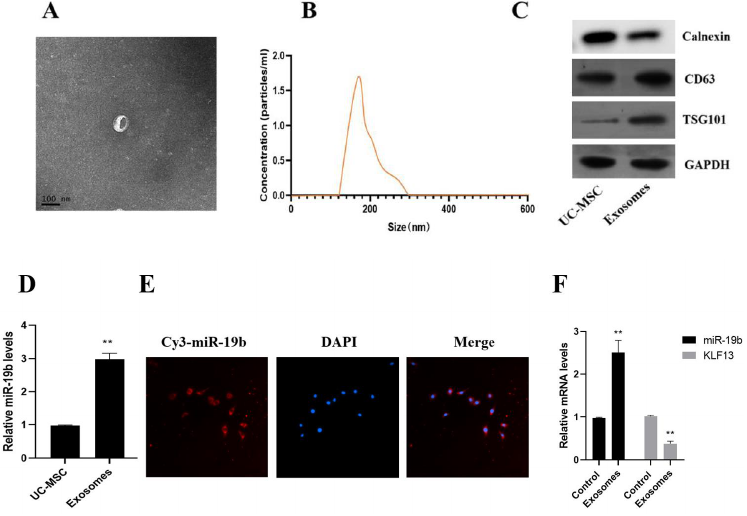
Figure 5. Isolation and characterization of exosomes in UC-MSCs. ( A ) Transmission electron micro- scope image of exosome morphology (scale bar: 100 μ m), ( B ) Size distribution of exosomes, ( C ) CD63 and TSG101 expression, ( D ) UC-MSC exosomes expression of miR-19b in exosomes, ( E ) uptake of exosomes by PBMC cells (scale bar = 25 μm) ( F ) the expression of KLF13 and miR-19 in PBMC cells after UC-MSC exosome treatment for 48 h compared to the control group. ** p < 0.01.